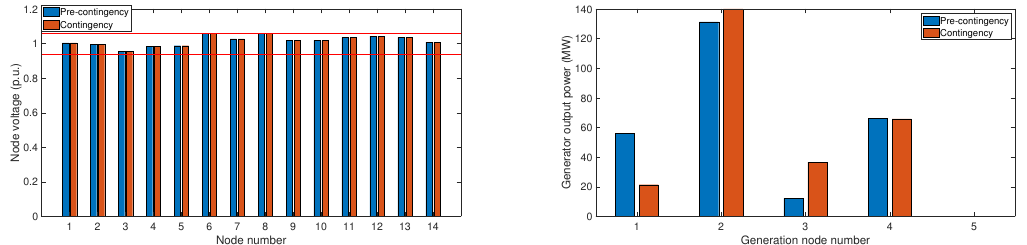
Figure 13. Voltage and power dispatched in the extended power system prior to and after contingency of branch 10 (generation nodes are, respectively, nodes 1, 2, 3, 6, and 8).